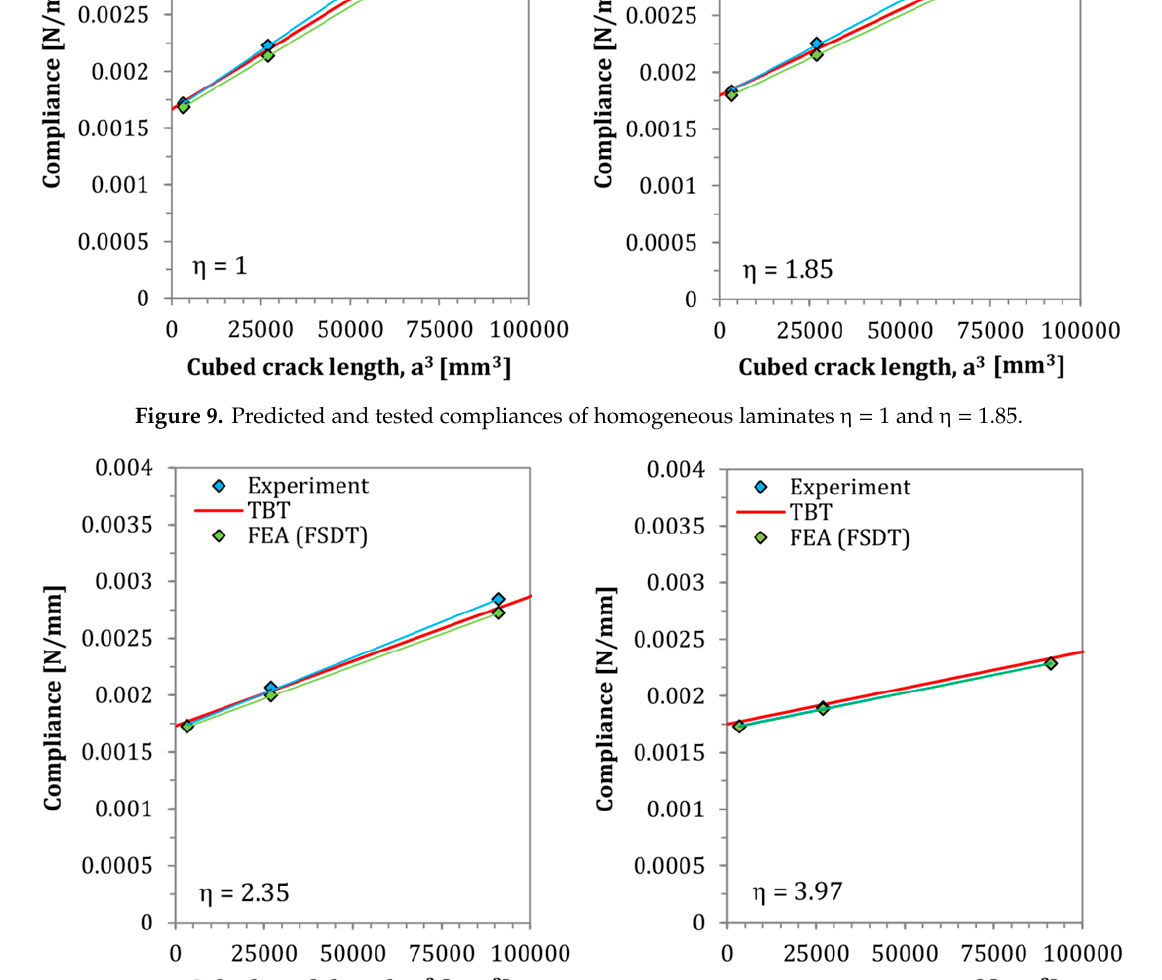
Figure 10. Predicted and tested compliances of homogeneous laminates η = 2.35 and η = 3.97.